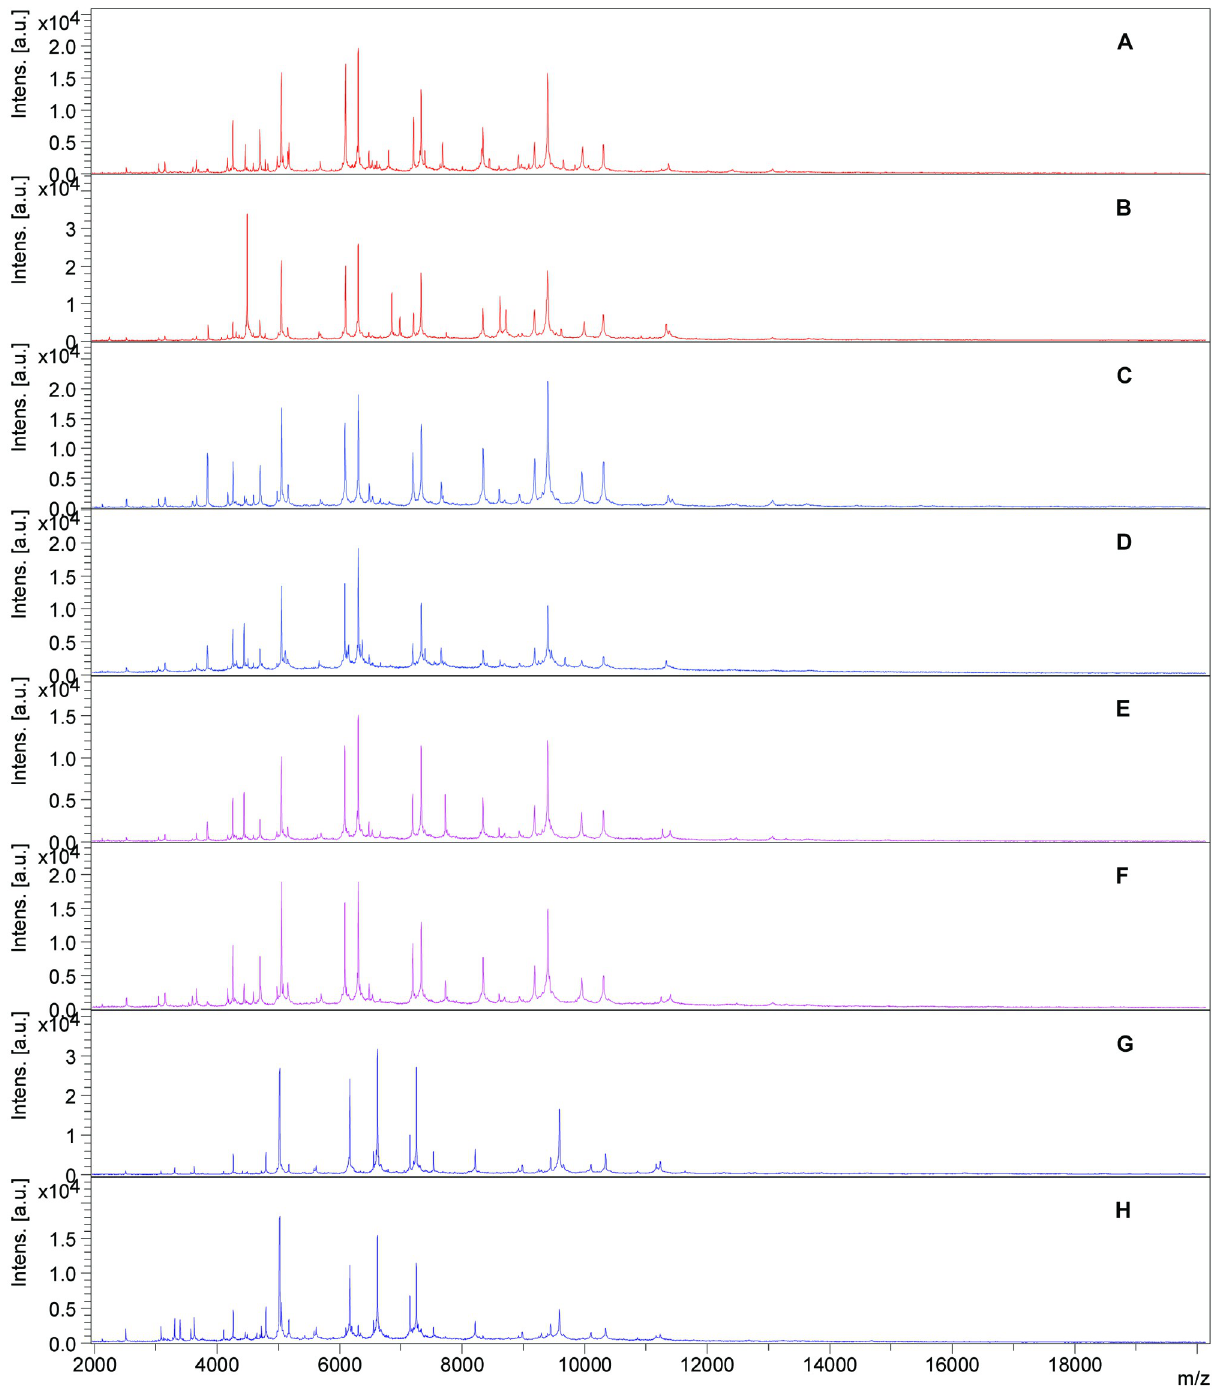
Fig 1. Representative MALDI-TOF mass spectra derived from analysis of bacterial isolates from the riverine freshwater (tributaries of the river Drava, Croatia) and fish from the respective water bodies. Mass spectra are as follows: Aeromonas veronnii A) from water, B) from fish; A . popoffii C) from water, D) from fish; A . bestiarum E) from water, F) from fish; Shewanella baltica G) from water, H) from fish.